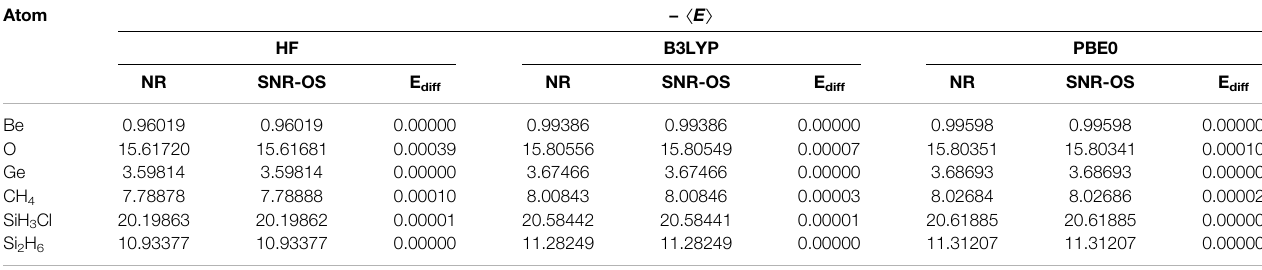
TABLE 7 | HF, B3LYP, and PBE0 energies (a.u.) of atoms and molecules. E diff = | E NR − E SNR-OS |. These are adopted from Ghosal et al. (2019). Atom